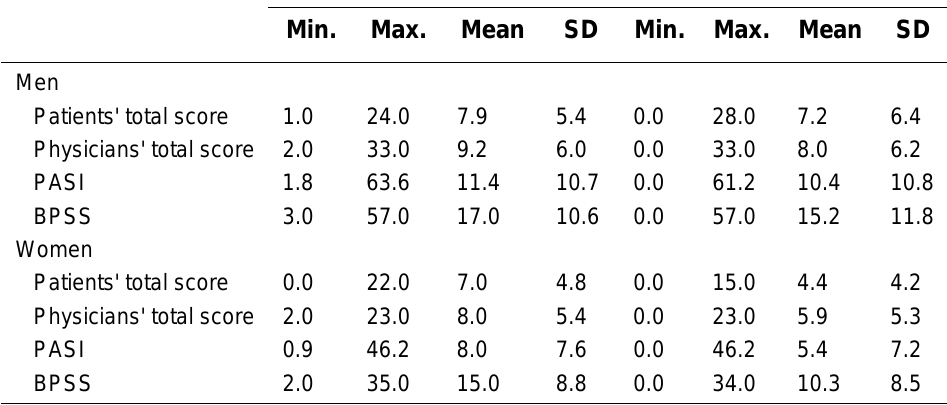
Assessment of Psoriasis Severity Before and After QoolSkin Treatment, Stratified by Gender